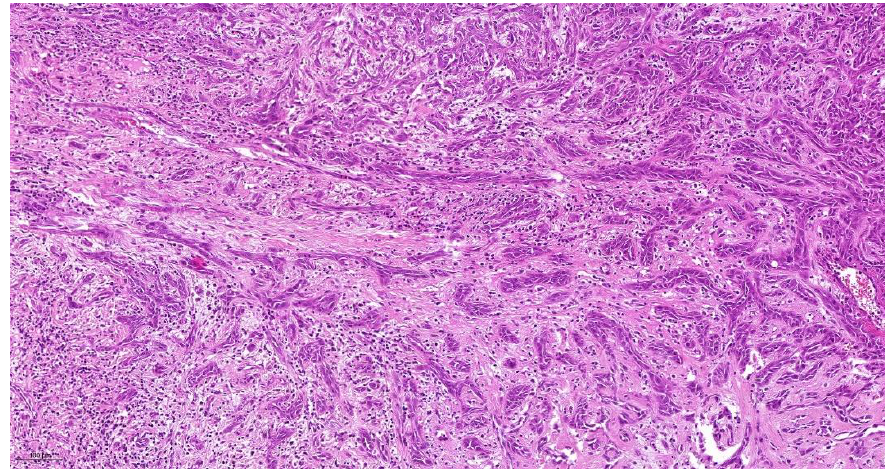
Figure 3. CNS(4) + TB(3) = CDG-3 _10.0 × . Table 1. Cellular dissociation grading [4 – 11].